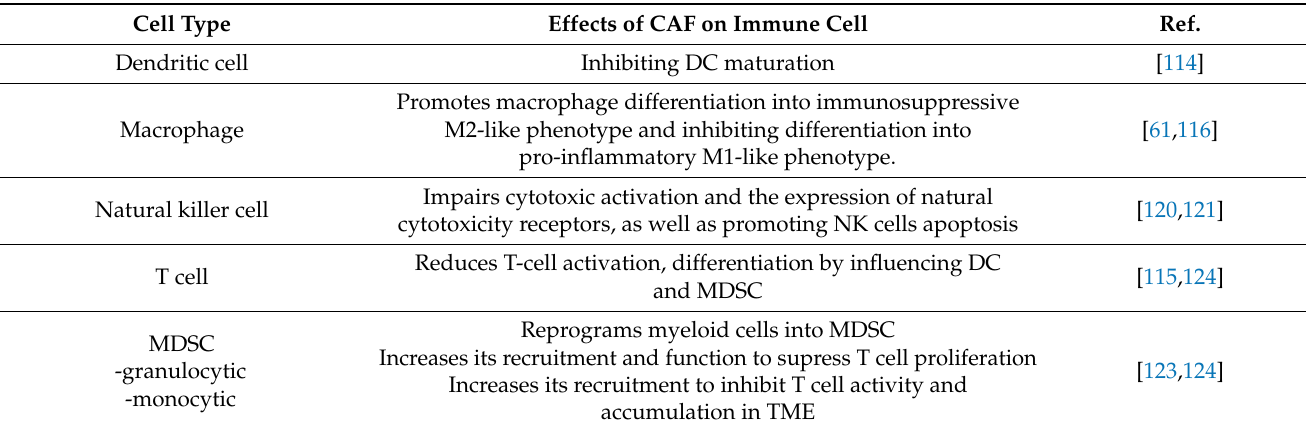
Table 1. Immunosuppressive effects of CAFs in the TGF- β 1-mediated fibrotic